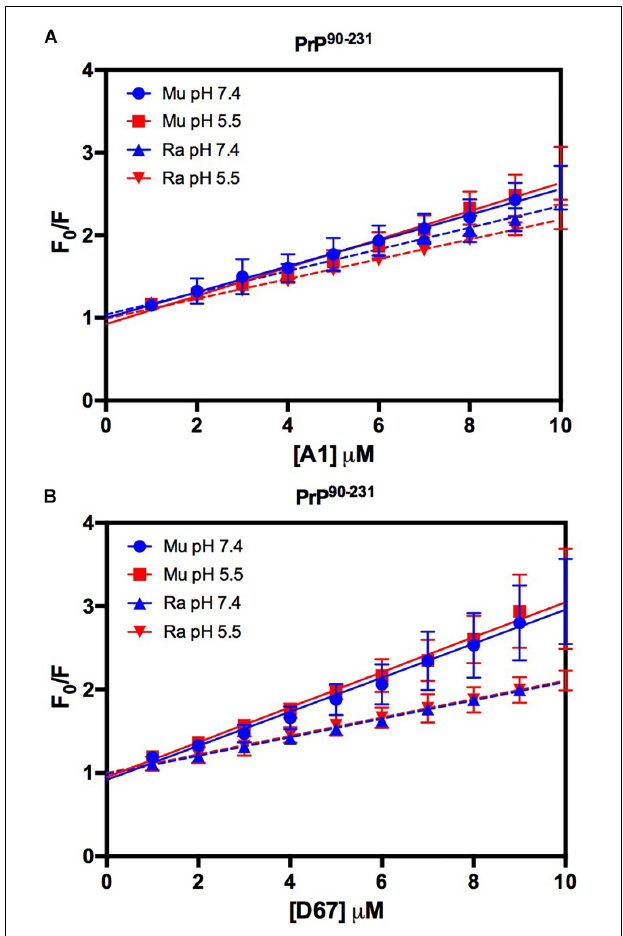
FIGURE 9 | RaPrP 90 − 231 interacts less with the DNA oligonucleotides. F 0 /F curves for titrations of A1 (A) and D67 (B) on PrP 90 − 231 at pH 5.5 (red) or 7.4 (blue). The curves were performed with 5 µ M PrP 90 − 231 and increasing concentrations of oligonucleotides (from 1 to 10 µ M). The experiments were performed in 50 mM Tris buffer containing 100 mM NaCl at pH 7.4 or 20 mM sodium acetate buffer containing 100 mM NaCl at pH 5.5. All experiments were performed at 25 ◦ C. The error bars represent the standard deviation of at least two independent